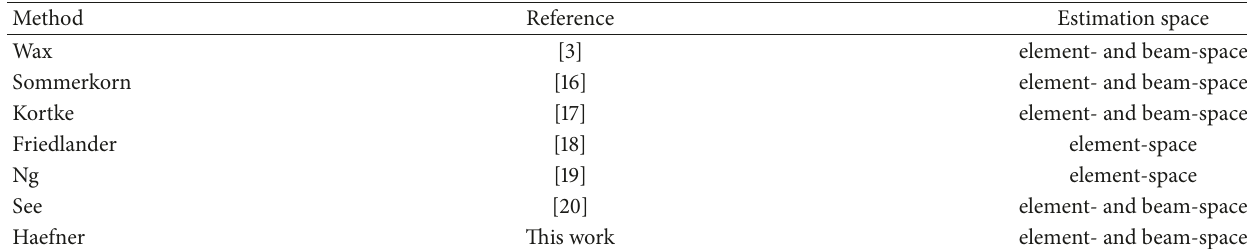
Table 2: Considered methods to estimate calibration matrix C .